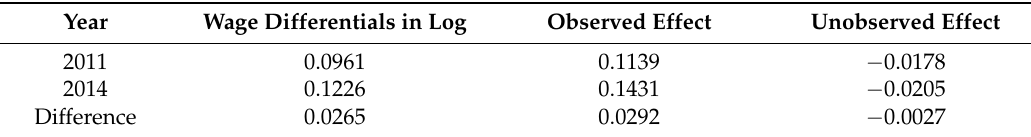
Table 6. Juhn-Murphy-Pierce decomposition method (Stage 1).